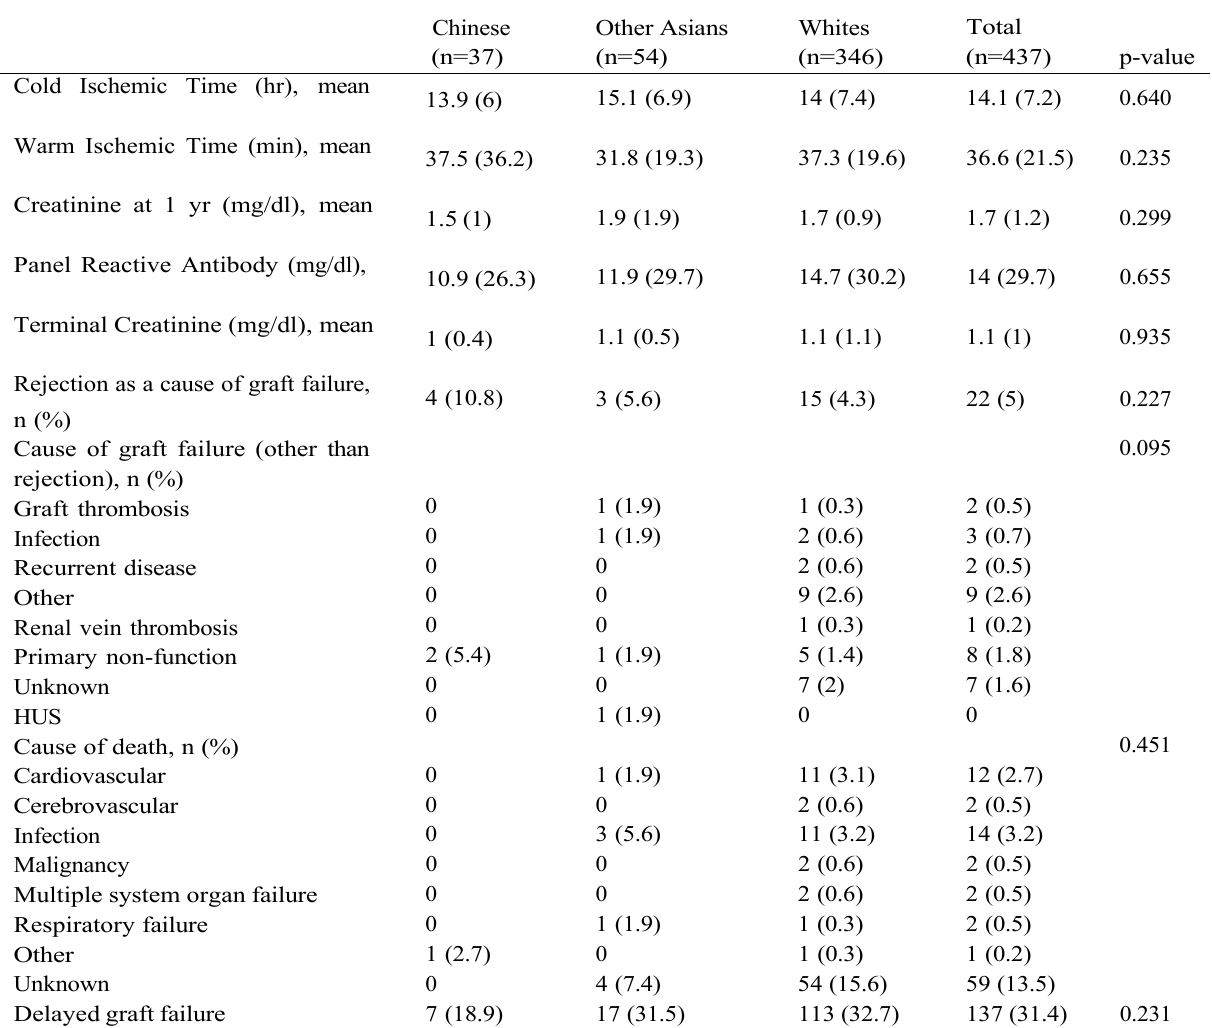
Table 4: Intraoperative and postoperative variables consisted of cefazolin. Cefazolin-allergic patients received vancomycin. Cytomegalovirus prophylaxis with renal dose- adjusted valganciclovir (maximum 450 mg daily) was given for six months universally. Other infection prophylaxis included Pneumocystis pneumonia prophylaxis with sulfamethoxazole-trimethoprim for six months and fungal prophylaxis with clotrimazole for four weeks